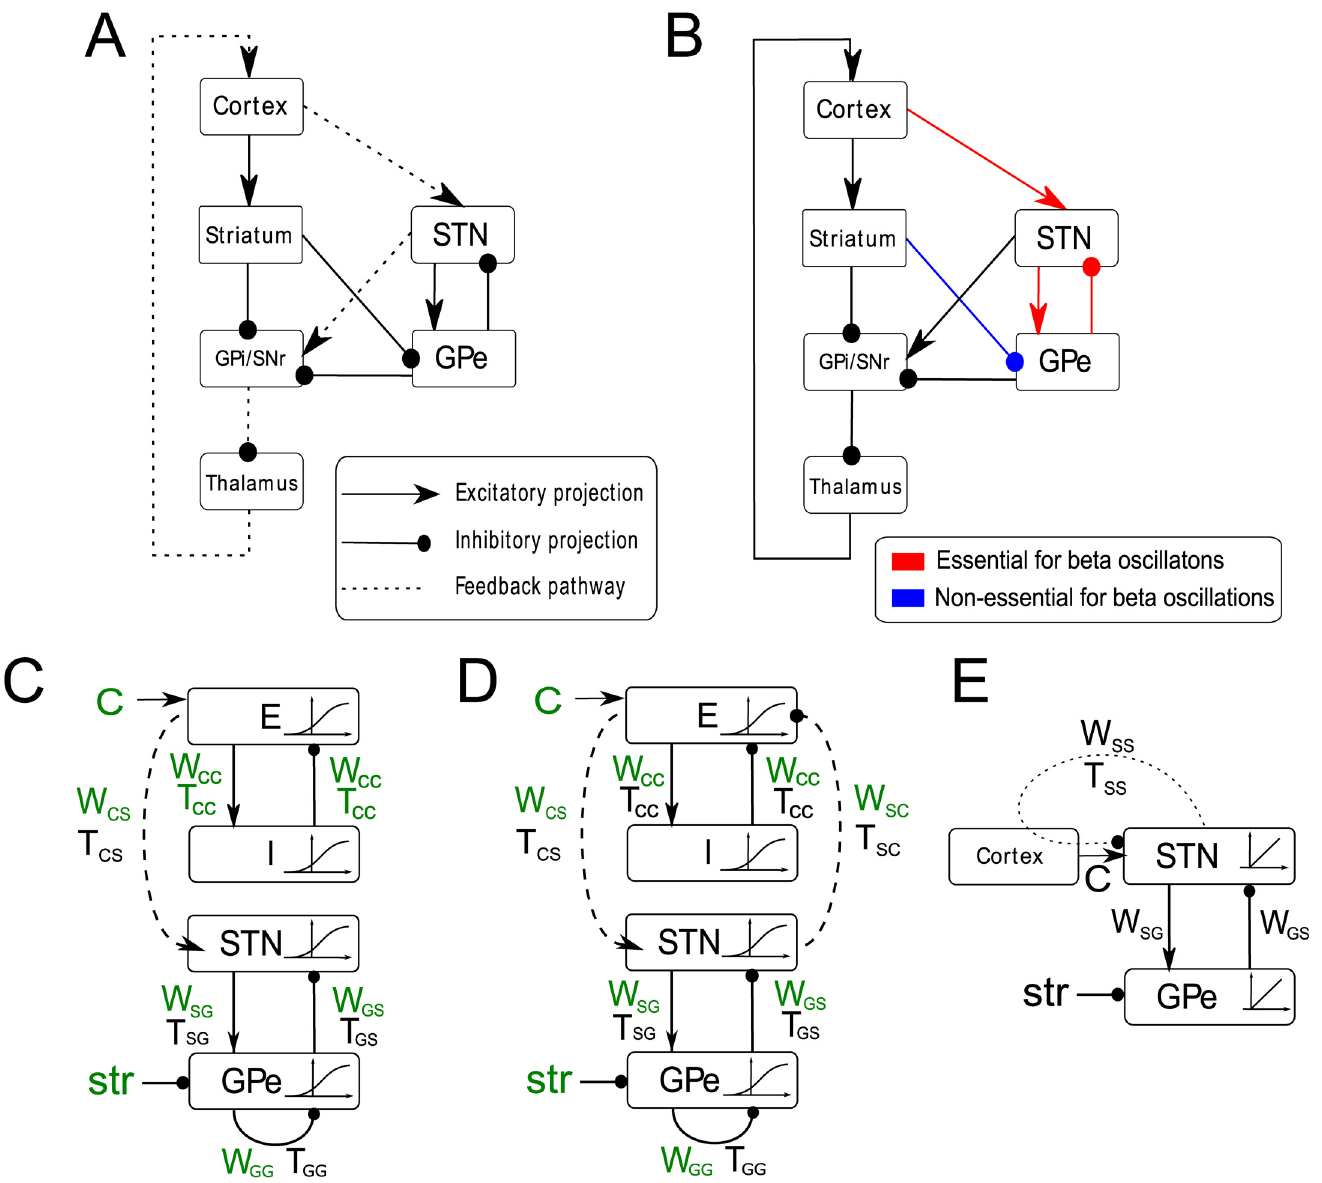
Fig 1. Connectivity in cortico-basal-ganglia-thalamic circuit and in the computational model. A) Major connections of the basal ganglia. Arrows denote excitatory connections and lines ending with circles denote inhibitory connections. The pathway which denotes cortical feedback via the hyperdirect pathway is highlighted with dashed lines. B) Summary of selected results of Tachibana et al. [14], who recorded activity of STN and GPe neurons in intact monkey model of Parkinson ’ s disease, and after blocking various inputs to the neurons in the vicinity of the recording electrode. Red lines indicate inputs that when blocked caused suppression of beta oscillations while the blue line indicates the striatal input to the GPe that when blocked did not reduce significantly the power of beta oscillations in the activity of recorded GPe neurons. C) A resonance model which includes time delays between the excitatory and inhibitory populations of the cortex, time delays between STN and GPe populations, time delays in the inhibitory GPe-GPe connections and further time delays connecting the cortex to the STN. This model also includes sigmoid activation functions for the STN, GPe, E and I populations which describe the input- output relationships of neurons in the populations. w ij and T ij denote the strength and delay of synaptic connections between neural populations i and j , where i and j can be equal to C for cortex, S for STN or G for GPe. Parameters shown in green are being fitted to the data. D) A feedback model that is identical to the model in panel C apart from including the time delayed connection between the STN and cortex, which forms a feedback loop between STN-GPe circuit and cortex. E) A linear model with time delay only in the cortical feedback.